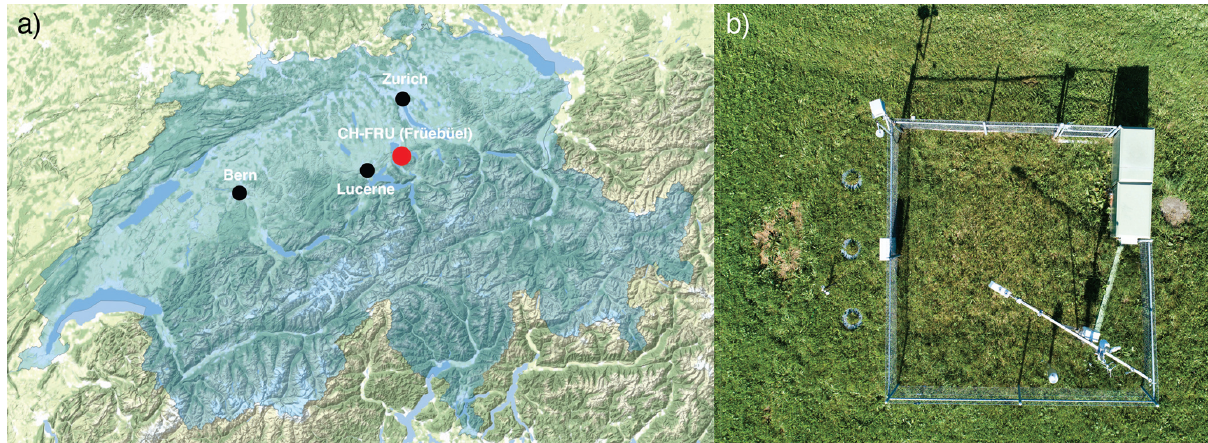
Figure A1. (a) The red dot indicates the location of the CH-FRU site within the Swiss borders (blue). The black dots indicate the cities of Zurich, Bern, and Lucerne. Map tiles by © Stamen Design, under CC BY 3.0. Data by © OpenStreetMap, under ODbL. (b) Aerial photograph taken with a drone of the CH-FRU site. On the left of the fenced area the three MLs are